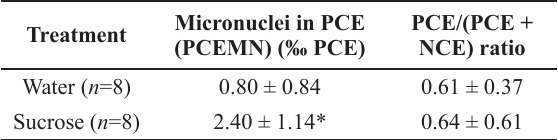
Influence of sucrose on markers of chromosomal mutations (micronucleus) in rats. Treatment